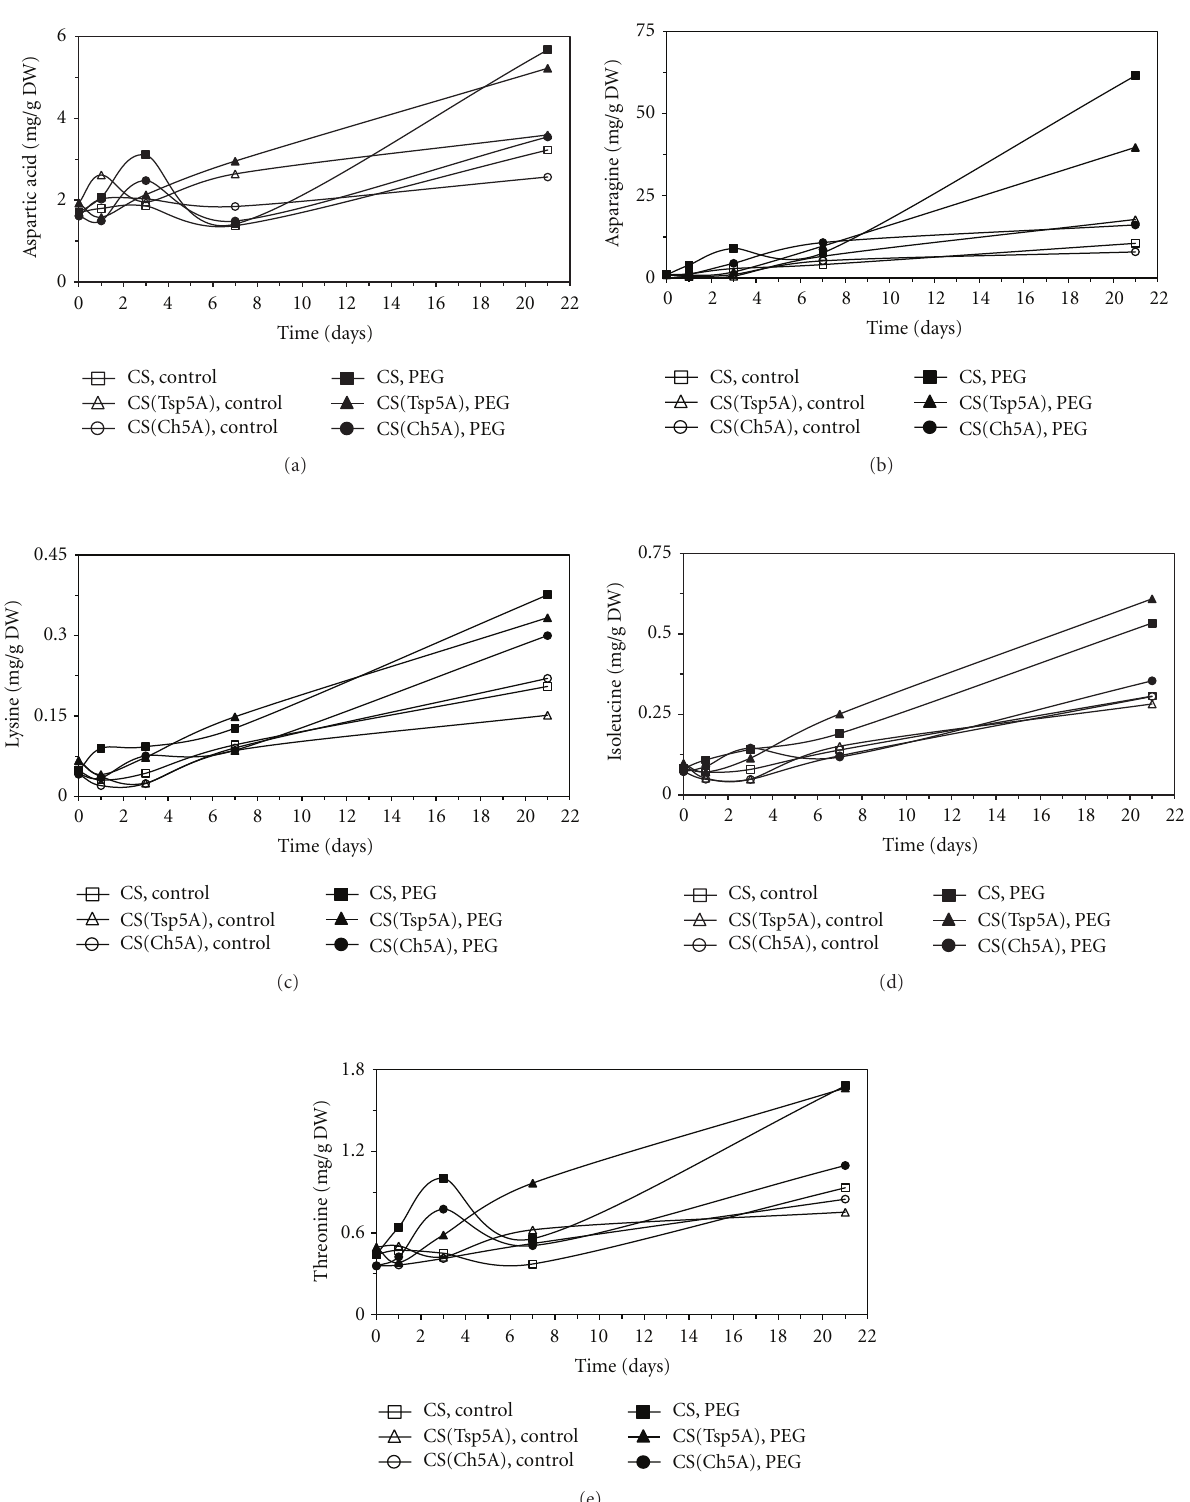
Figure 5: E ff ect of osmotic stress on the concentration of amino acids belonging to the aspartate family. The time course of changes was compared under control and stress (15% PEG) conditions in the freezing-sensitive CS and CS(Tsp5A) and the freezing-tolerant CS(Ch5A) wheat genotypes. The standard deviations of the data were below 10% in each case (not shown on the graphs because of the better transparency). (a): Asp (SD: 0.505), (b): Asn (SD: 5.92), (c): Lys (SD: 0.037), (d): Ile (SD: 0.050), and (e): Thr (SD: